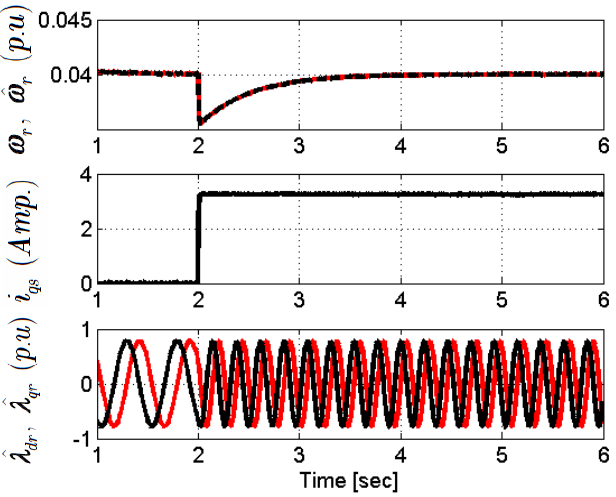
Figure 9. Simulation tests at low speeds. Speed reference of 0.04 p.u (6.28 rad/s) with rated T L change of +7 N.m at t = 2 s.